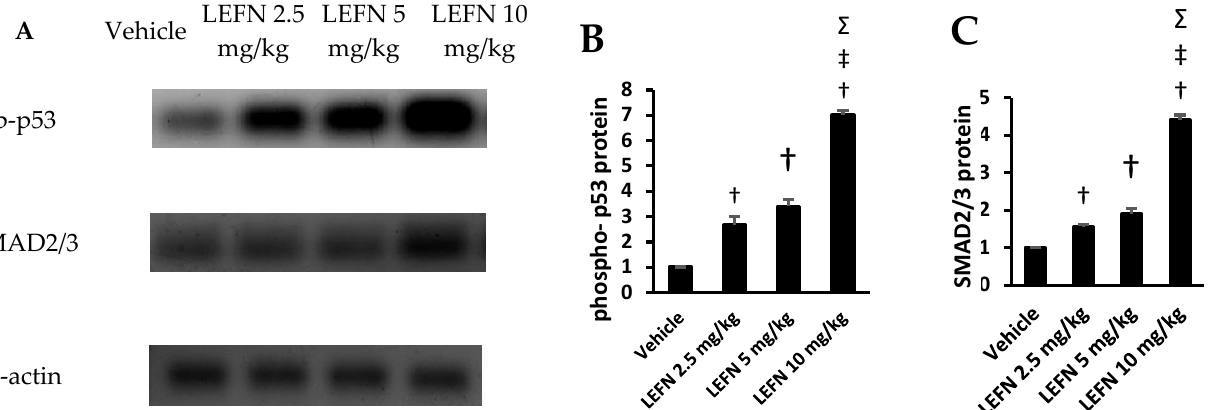
Figure 10. Western blot analysis for the target proteins. ( A ) The Western blot gels for p-p53, SMAD2/3, and SMA compared to β-ACTIN. ( B , C ) Column charts for the p-p53 and SMAD2/3 in the experimental groups. Data are mean ± SD. †: versus the vehicle group, ‡: versus the LEFN 2.5 mg/kg group, and Σ: versus the LEFN 5 mg/kg group at p < 0.05.